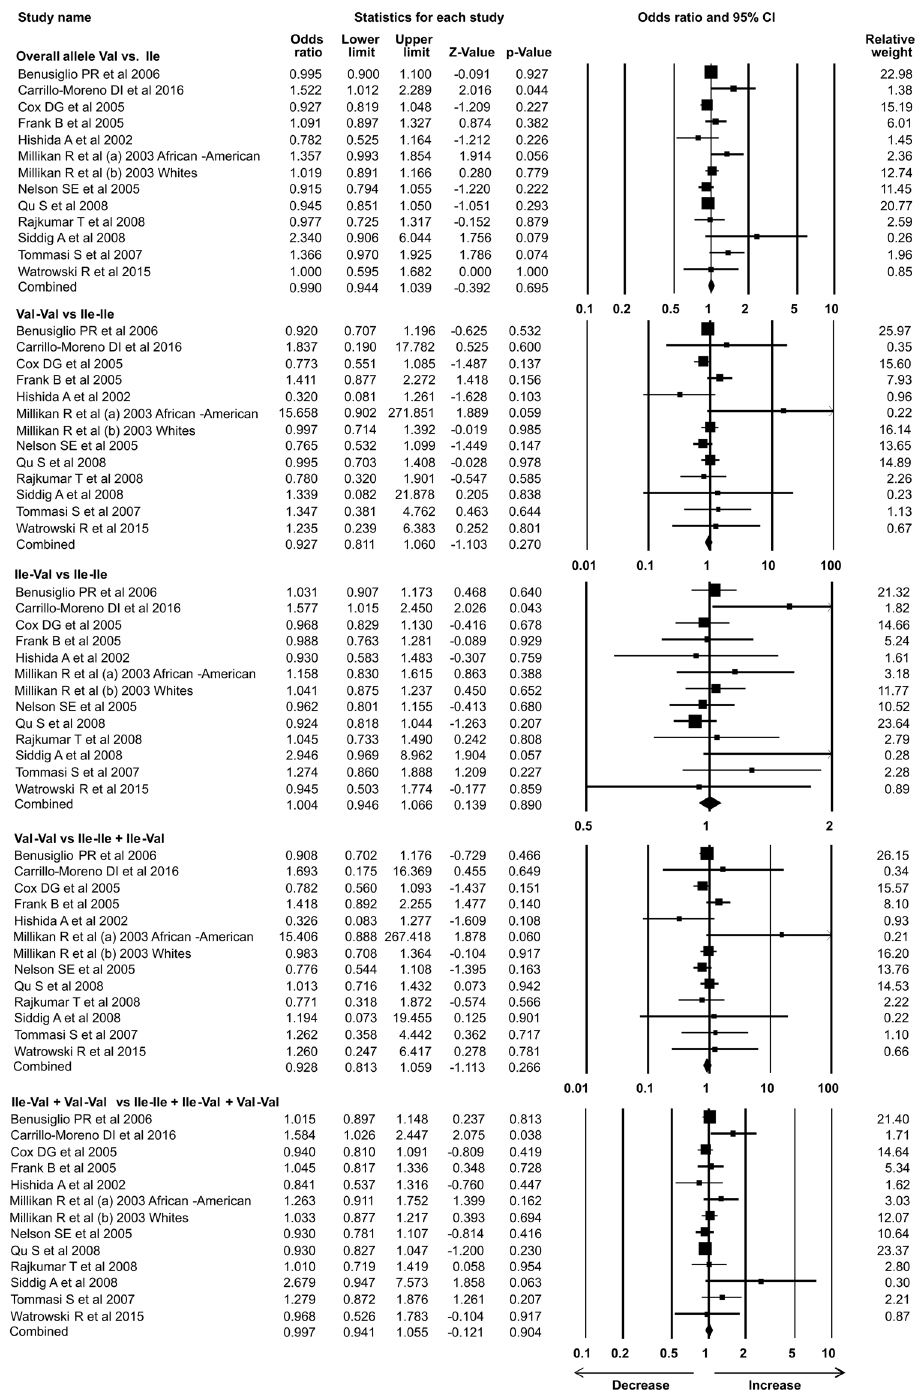
Figure 6. Forest plot: Overall allele and genotypic analysis of studies in which Taqman used as detection method for Her2 Ile 655 Val (rs1136201) gene polymorphism and evaluation of its association with breast cancer risk. Black squares represent the value of OR and horizontal line indicates 95% Confidence Interval (CI) of odds ratio (OR). Overall allele Val vs Ile: OR = 0.990, 95% CI = 0.944–1.039, p = 0.695; Homozygous Val-Val vs Ile- Ile: OR = 0.927, 95% CI = 0.811–1.060, p = 0.270; Heterozygous Ile-Val vs Ile-Ile: OR = 1.004, 95% CI = 0.946– 1.066, p = 0.890; Recessive Val-Val vs Ile-Ile + Ile-Val: OR = 0.928, 95% CI = 0.813–1.059, p = 0.266; Dominant model Val-Val + Ile-Val vs Ile-Ile: OR = 0.997, 95% CI = 0.941–1.055, p =